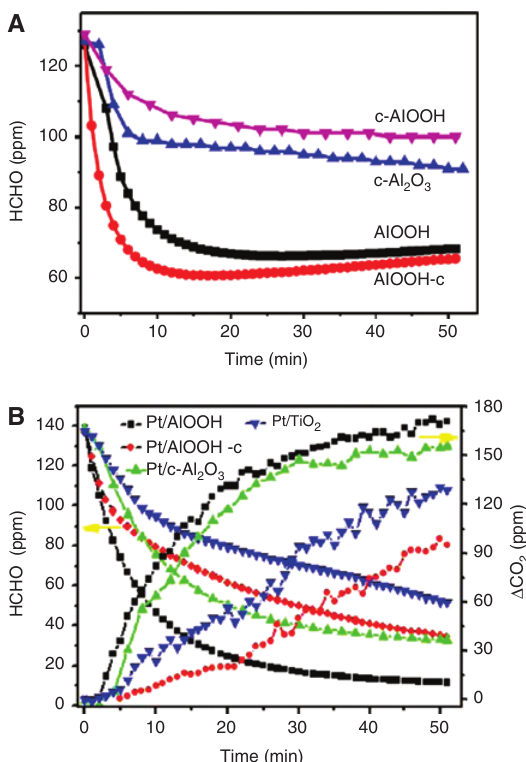
Figure 4: (A) The concentration change of formaldehyde as a function of test time on AlOOH, AlOOH-c (calcined AlOOH), c-AlOOH (commercial AlOOH) and c-Al tion change of HCHO and CO AlOOH, Pt/AlOOH-c, Pt/c-Al from [32] with permission from Elsevier